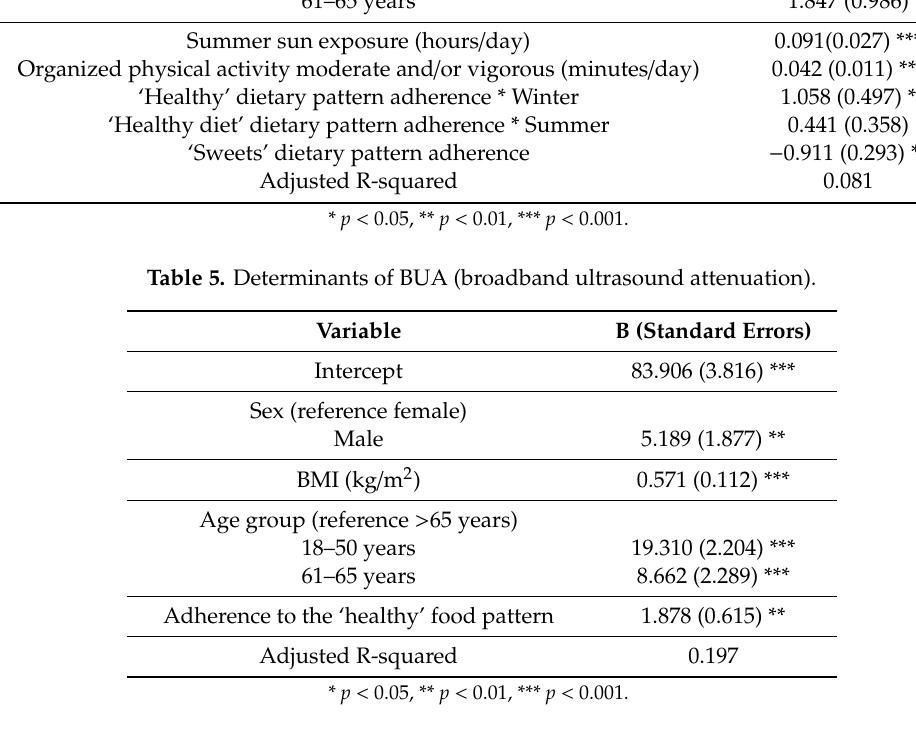
Table 6. Determinants of SOS (speed of